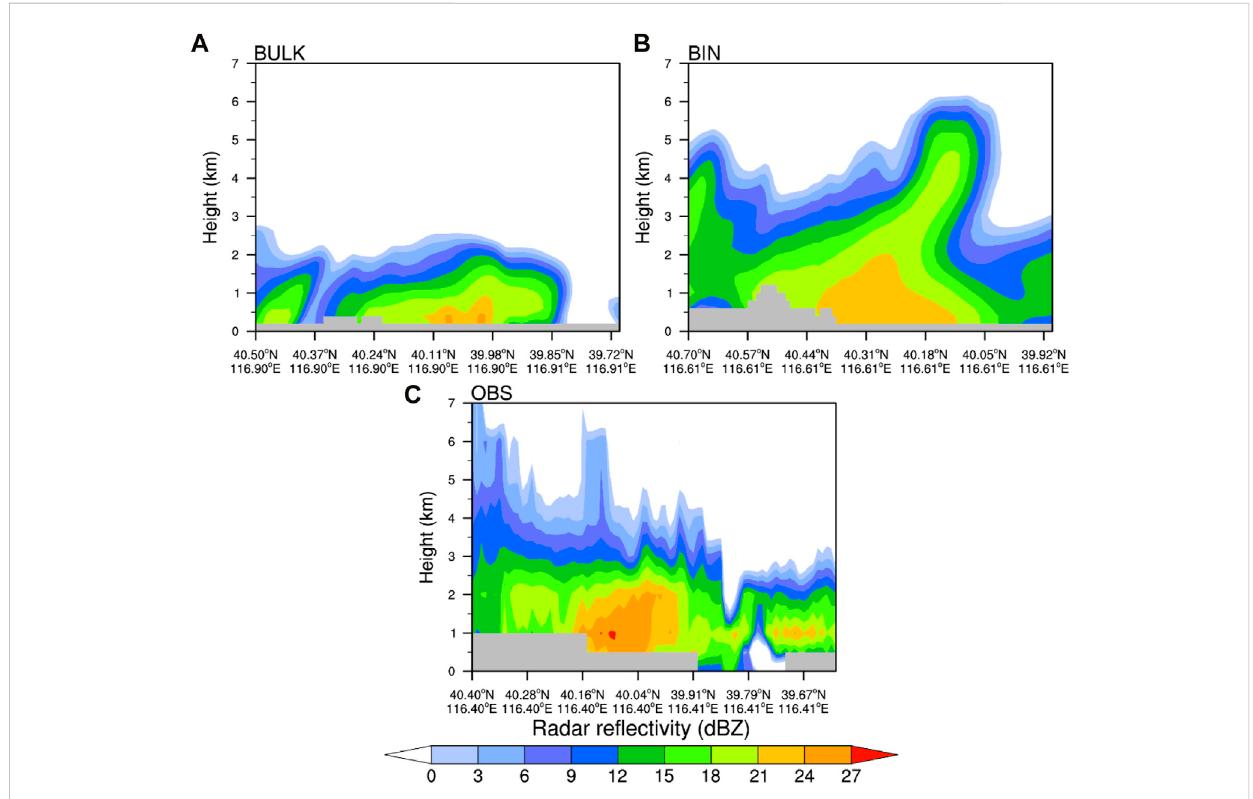
As in Figure 6 but for vertical cross sections of radar re fl ectivity along the black lines shown in Figure 6. The gray zones in the fi gure indicate the